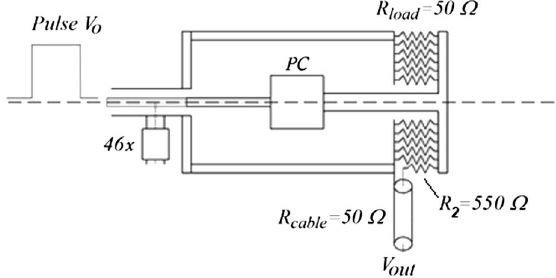
FIG. 2. Shunt calibration.